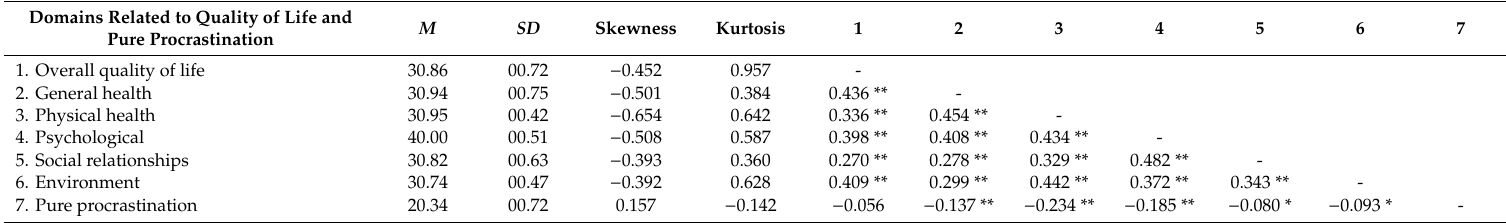
Table 1. Means, standard deviations, and intercorrelations for domains related to quality of life and pure procrastination. Domains Related to Quality of Life and M Pure Procrastination